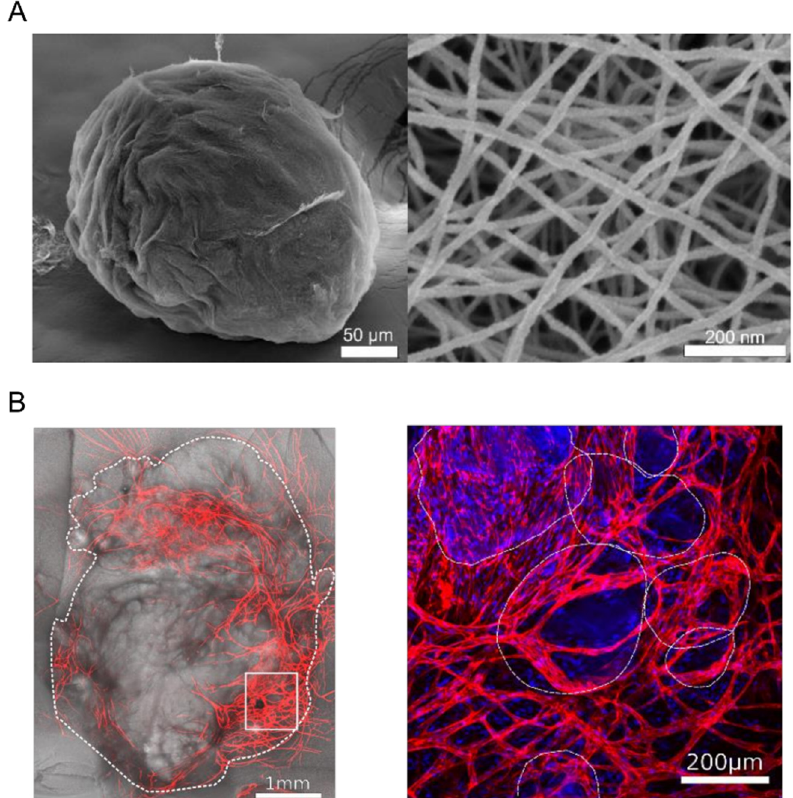
Figure 7. ( A ) SEM image of a single microgel (left) showing the round spherical shape and the network of fibers (right) resulting from the self-assembling of the ultrashort peptides . The f igures have been adopted from [108]. ( B ) Vascularization of 3D bulk hydrogel with embedded endothelial cell-laden microgels. Anti-CD31 Alexa Fluor (red) was used for the detection of endothelial cells. 4 ′ ,6-diamidino-2-phenylindole (DAPI) (blue) was used for the detection of nuclei. The right image is a zoom-in of the left image, and both images show that the vascular network originated from the embedded microgels and spread to the rest of the bulk hydrogel.